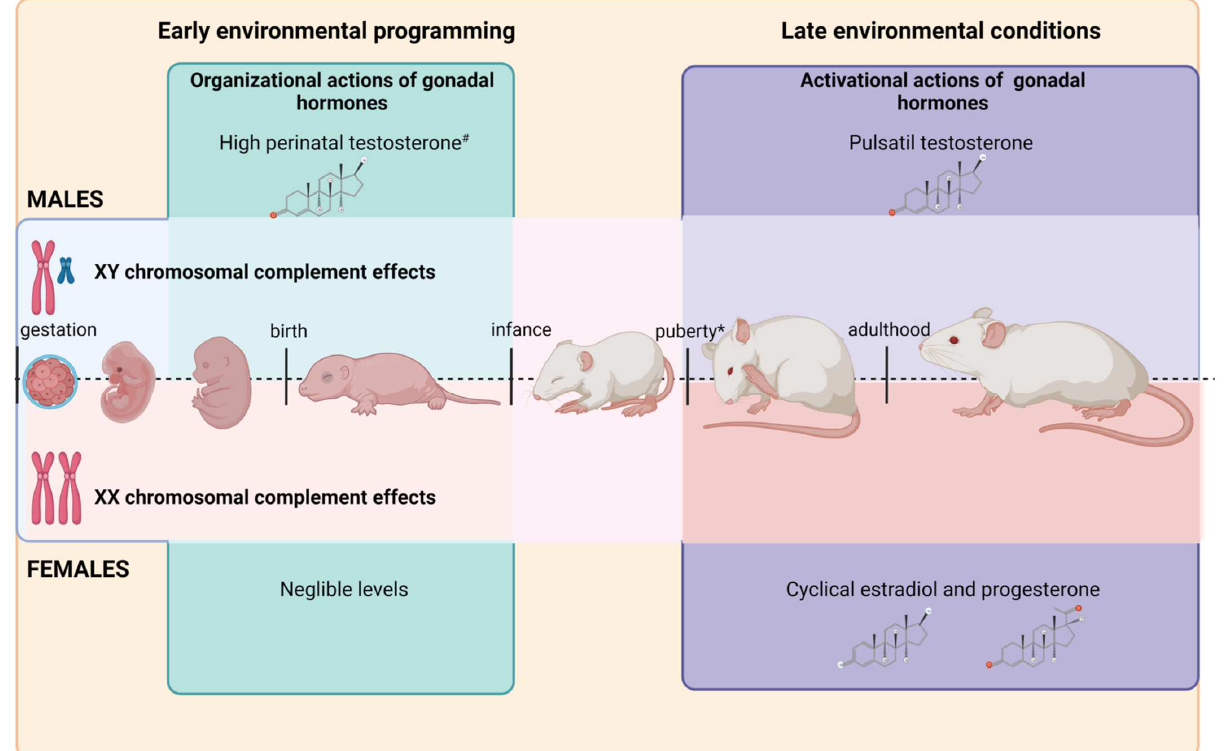
Figure 3. Unified model of sexual differentiation of brain and behavior. From gestation, sex chro- mosome complements orchestrate sexual differentiation of embryos by various Y and X genes. The expression of the Y exclusive gene Sry triggers the differentiation of bipotential gonads into testes, and their absence leads to ovaries development. Testosterone levels during the perinatal period in males (or their absence in females) interact with early environmental clues to modulate Y and X gene expression. Later in life, environmental conditions, activational gonadal hormones actions and direct genetic factors interact on early organized circuits to induce, deepen, or erase sex differences in brain and behavior. # Much of the testosterone actions are indeed mediated by estradiol and dihydrotestosterone metabolized in situ [70,71]. * Rapid rise of gonadal hormones at puberty has their own organizational effects [72]. Created with BioRender.com (accessed on: 20 December